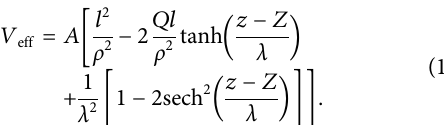
Frontiers in Physics |